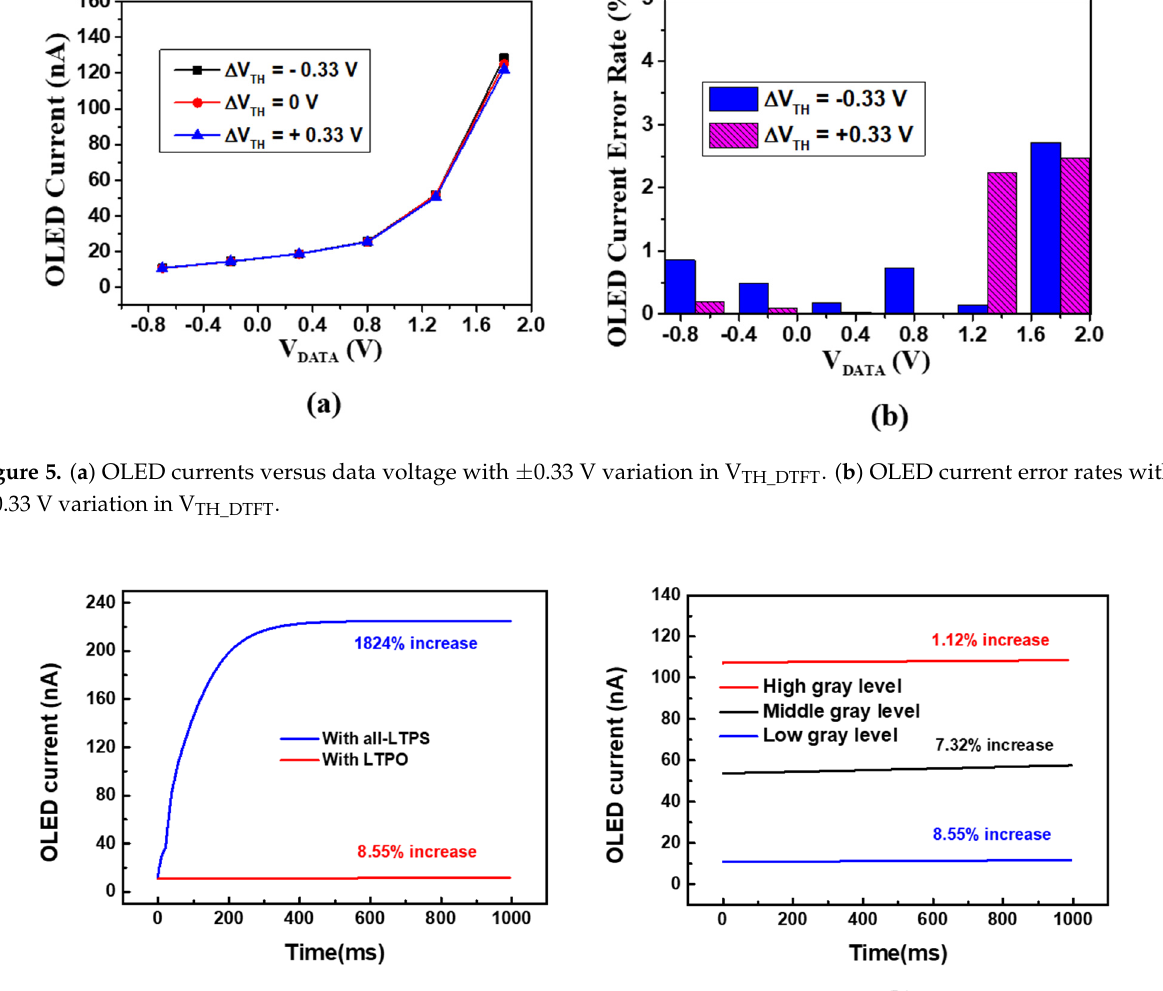
Figure 5. ( a ) OLED currents versus data voltage with ±0.33 V variation in V TH_DTFT . ( b ) OLED current error rates with ±0.33 V variation in V TH_DTFT .